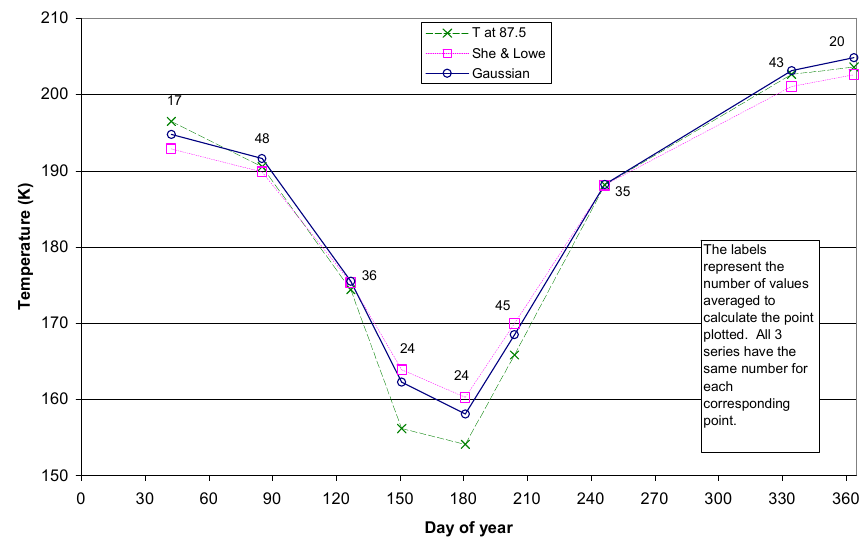
Fig. 6. A comparison of the temperature at 87.5km averaged over all of the profiles that comprise each cluster in Fig. 5 with the averaged OH-equivalent temperature calculated using (i) the She and Lowe (1998) volume emission rate weighting function, and (ii) the Gaussian weighting function centred on 87km with a full width at half maximum of 8.7km.